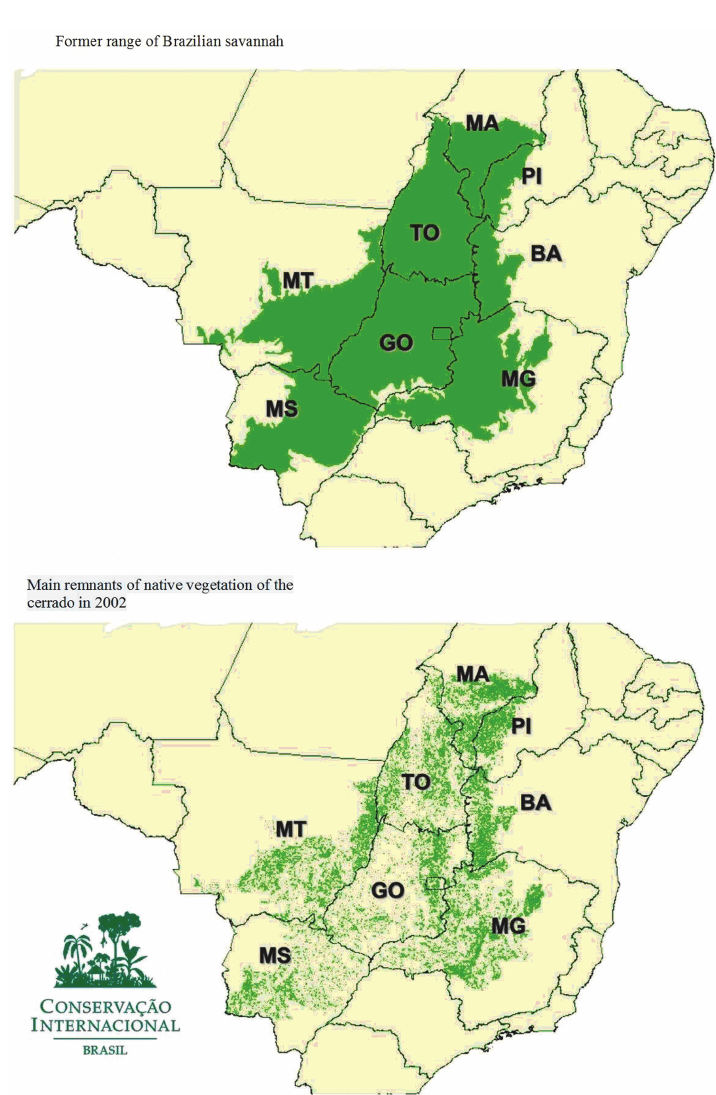
Fig. 1 – Map of Brazilian savannah regions. Source: < http://www.conservation.org.br/arquivos/Mapa%20desmat%20Cerrado.jpg >